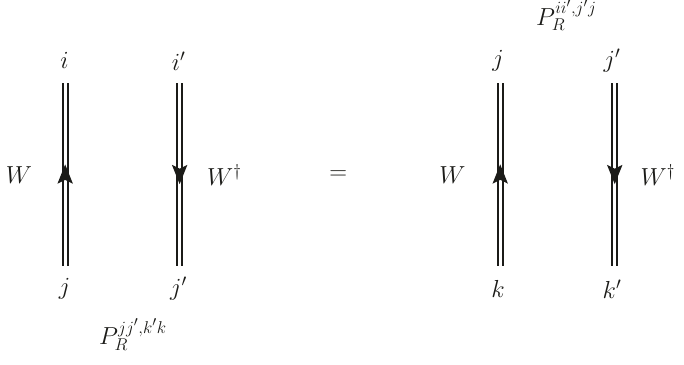
Figure 2. Graphical representation of the relation (4.38). The Wilson lines are understood to be interacting, i.e. any number of gluons may be attached to them in a Feynman graph. ′ aa ′ compensates the behaviour of P jj under complex conjugation. One easily checks A